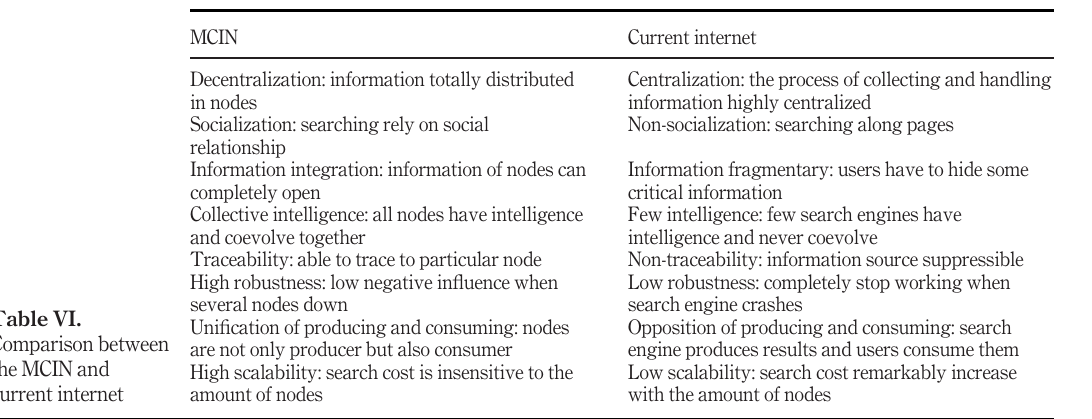
Figure 10. “ My space ” function module